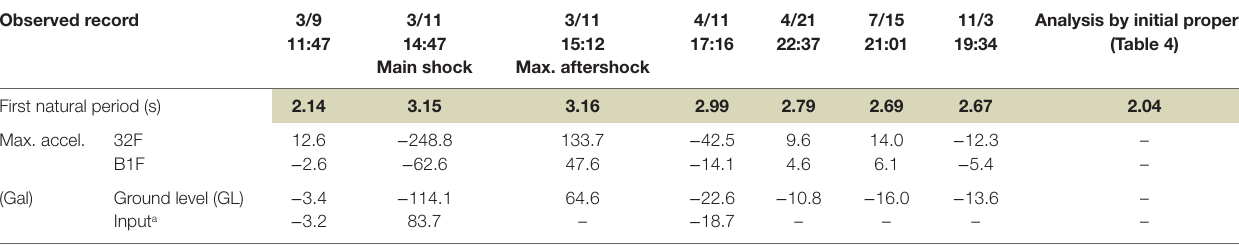
TaBle 2 | Temporal changes in the transfer function according to the natural periods of the building (N–S direction). Observed